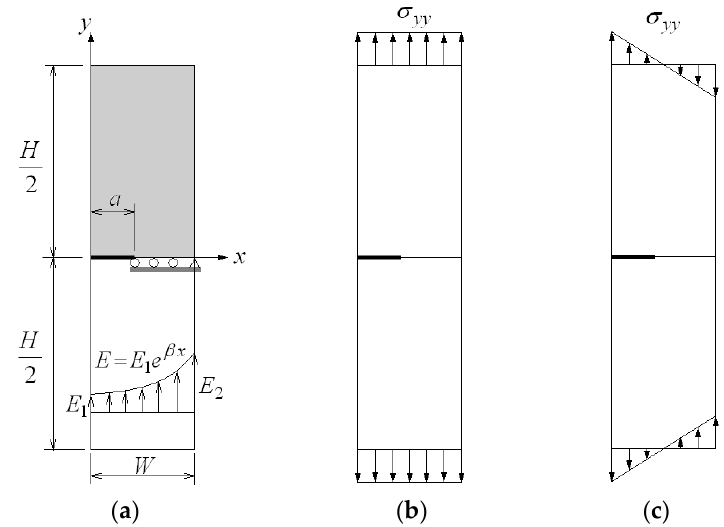
Figure 7. A cracked rectangular functionally graded material (FGM) plate with a varying Young’s modulus: ( a ) Geometry dimensions, ( b ) tension loading, ( c ) bending.